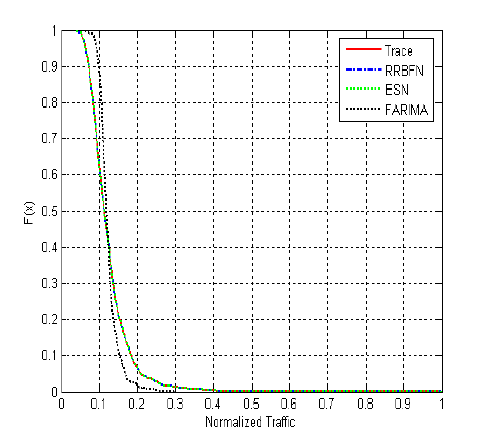
Fig. 6. 1-Step Traffic Prediction (10-Second Interval)